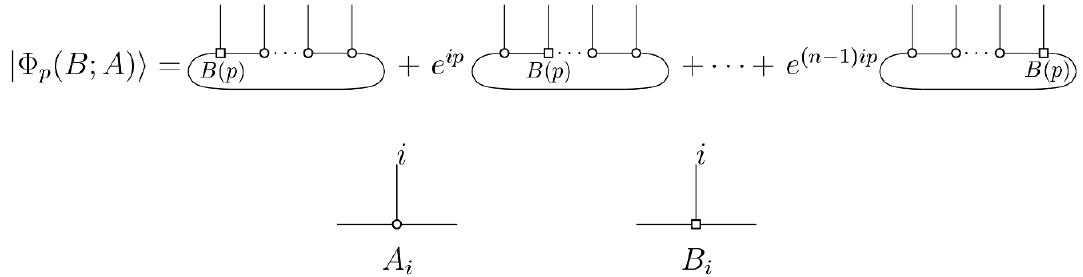
Figure 5 . This (cid:12)gure illustrates the excitation ansatz j (cid:8) p ( B ; A ) i for n physical spins. which is the state with a \single B ( p ) excitation" at site j . Note that we retain the p dependence in the de(cid:12)nition of these \position space" states since the B tensors themselves are generally p